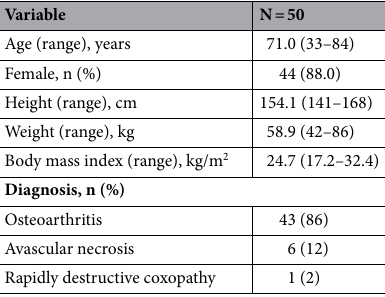
Table 1. Demographic characteristics of the enrolled patients.